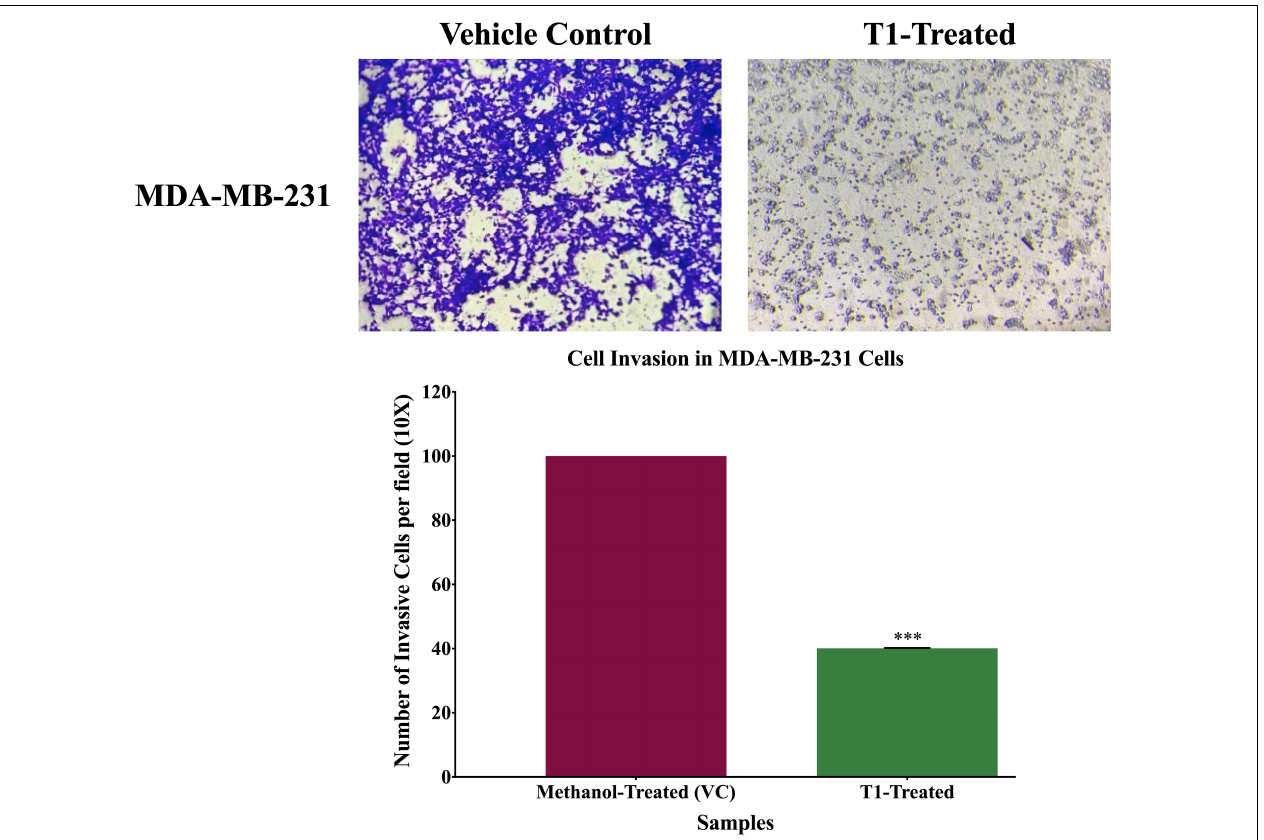
FIGURE 5 | Effect of T1-extract on cell invasion of MDA-MB-231 breast cancer cell line using Boyden chamber assay. T1-extract significantly decreased cell invasion ability of MDA-MB-231 by ∼ 60% in comparison to control cells (VC: vehicle control) (*** p <